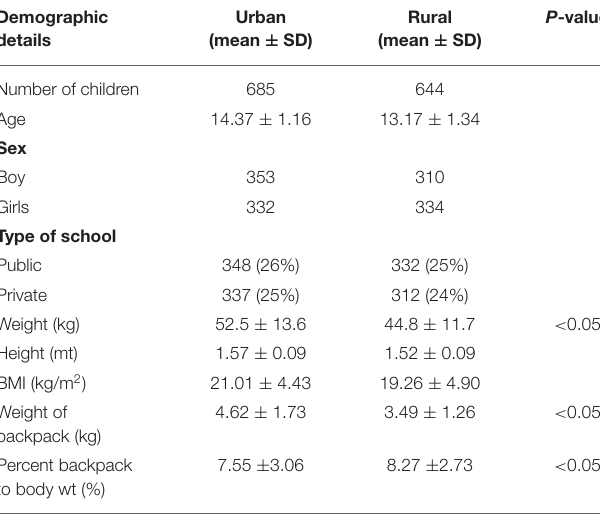
TABLE 3 | Association of backpack weight among public vs. private schools across